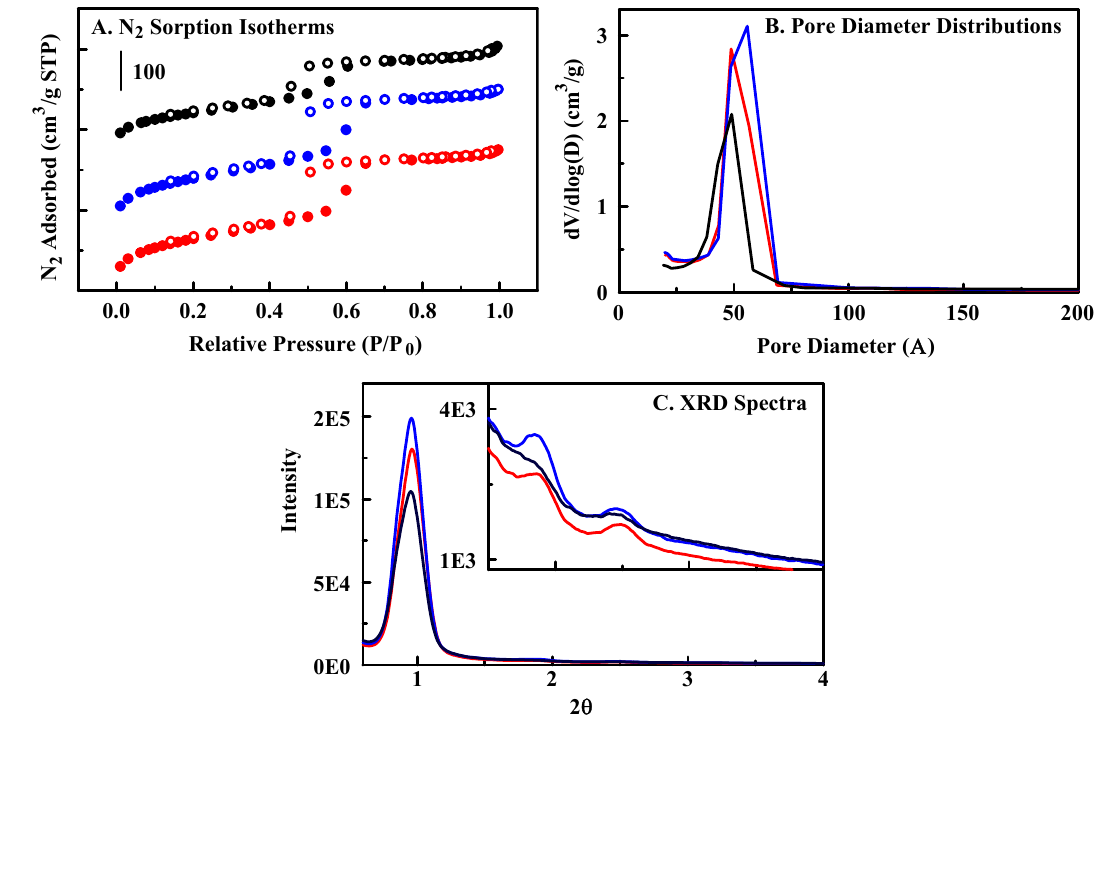
Figure 4. Structural characterization (Material 1 , red; Material 2 , blue; Material 5 , black). Panel A, nitrogen sorption isotherms offset by 0, 150, and 350 cm 3 /g, respectively. Panel B, pore size distributions. Panel C, XRD spectra (inset shows expansion of the 1.5 to 4